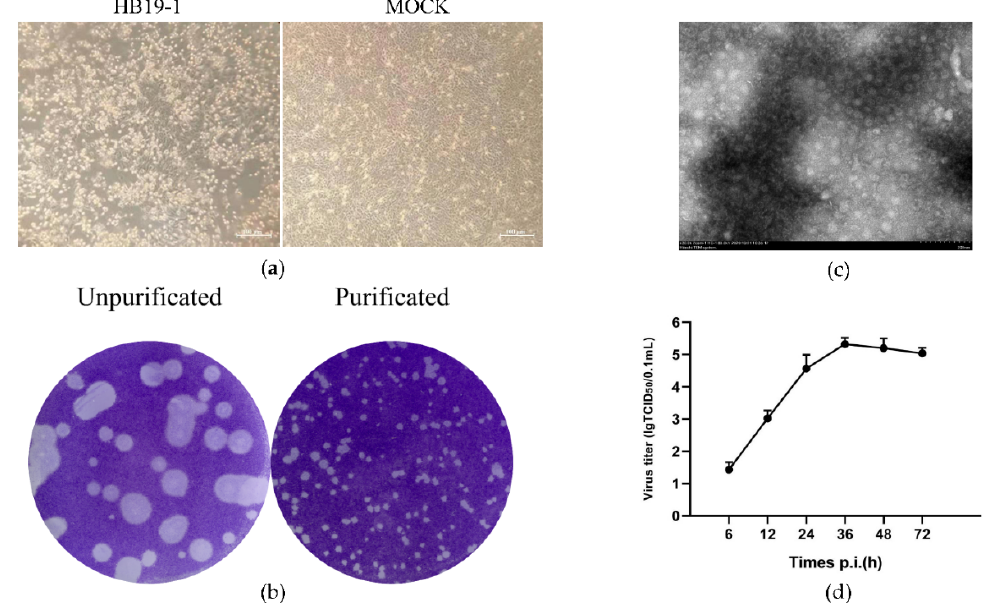
Figure 1. Isolation and identification of BEV HB19-1. CPE, plaque purification, electron microscopy, and growth curve of BEV HB19-1 in MDBK cells: ( a ) CPE caused by BEV HB19-1 in MDBK cells was characterised at 24 hpi; ( b ) plaques of impurified and purified BEV HB19-1 strain; ( c ) electron microscopy of purified BEV HB19-1 virions; ( d ) growth curve of BEV HB19-1 in MDBK cells.